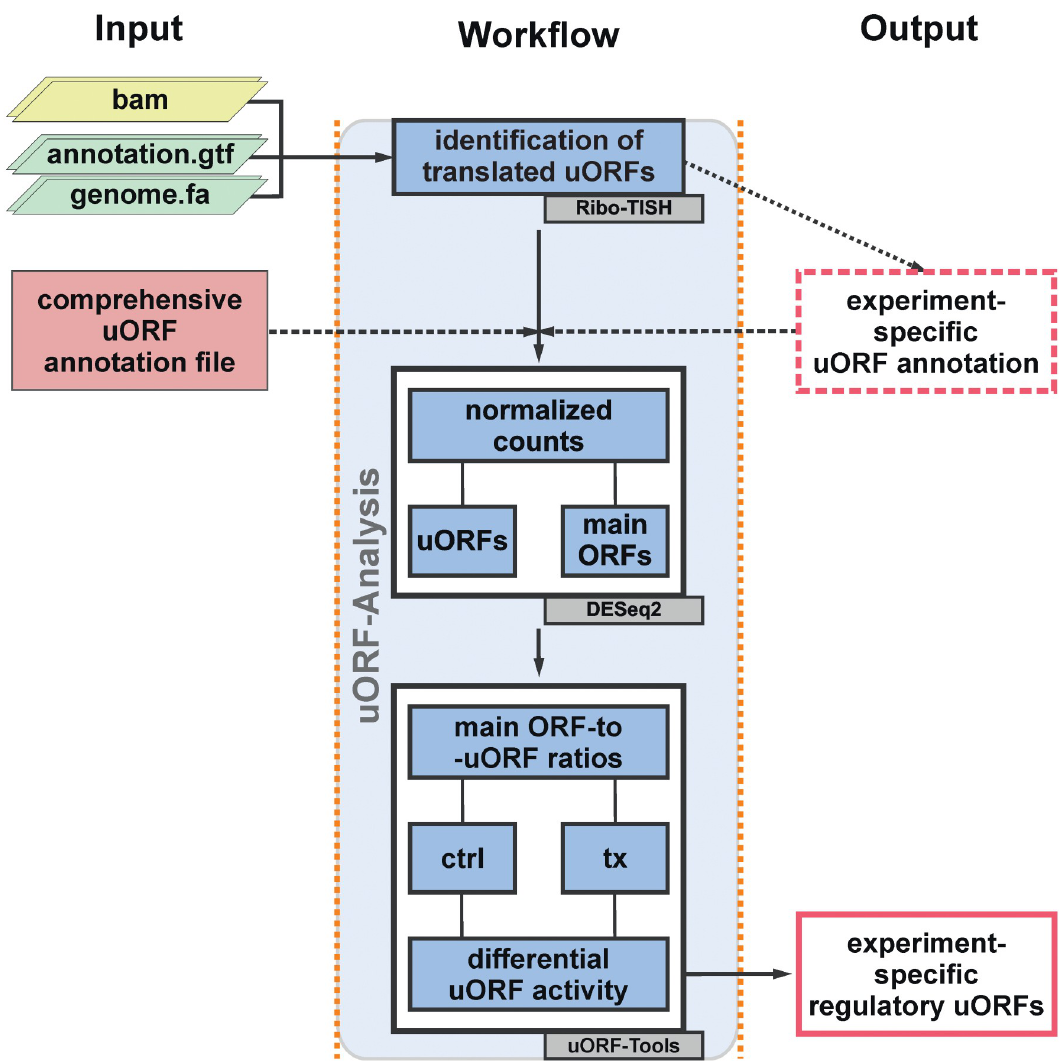
Fig 1. uORF-Tools —Workflow for the determination of translation-regulatory uORFs. Required input is shown on the left, a simplified depiction of processing in the center, and results on the right. (ctrl: control; tx: